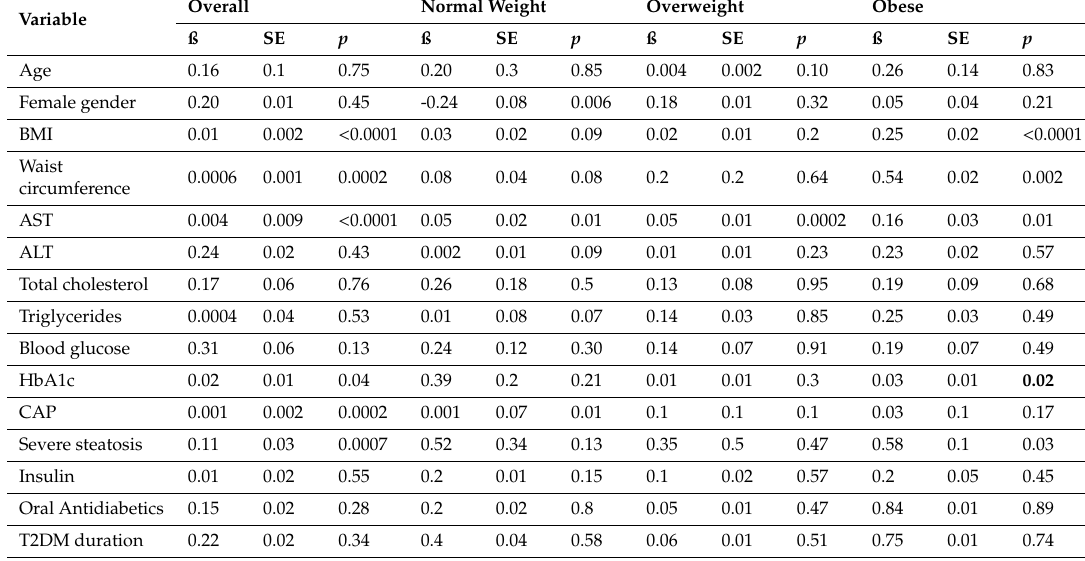
Table 5. Univariate analysis of factors associated with advanced